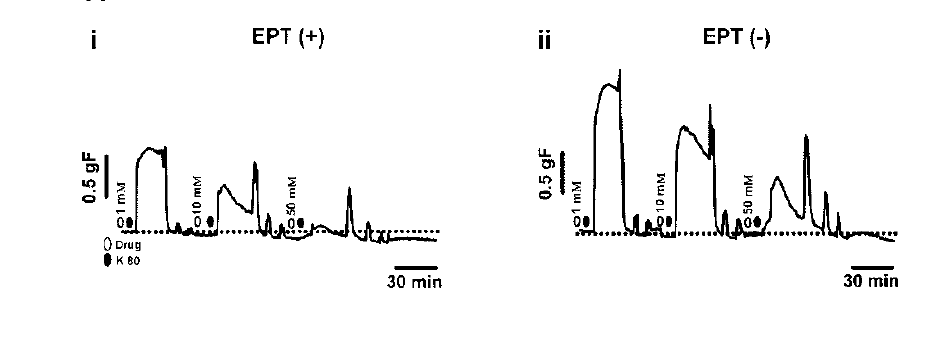
Figure 2. Representative experimental traces showing the relaxant effects of non-cumulatively increasing concentrations of trans -caryophyllene (0.3–50 mM) with (EPT(+), Ai ; n = 5) and without (EPT( − ), Aii ; n = 4) intact epithelium on the high K + -induced contraction (K 80) of rat isolated tracheal smooth muscle. ( B ) Concentration-response curves of trans -caryophyllene-induced relaxation. Closed triangles represent segments with intact epithelium and open circles without intact epithelium. Symbols are means ±